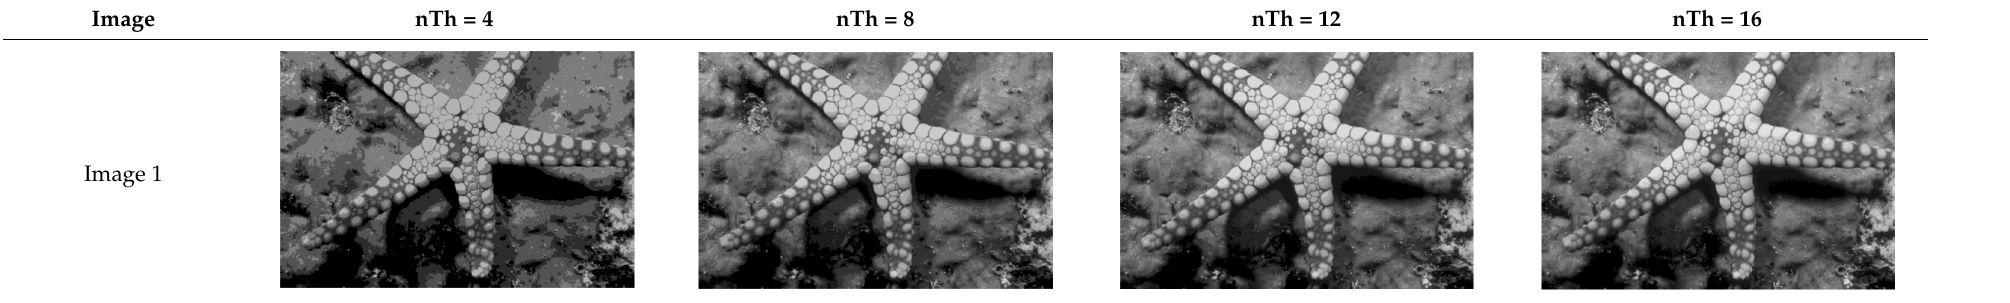
Table A2. The segmented images obtained by MROA using cross-entropy.